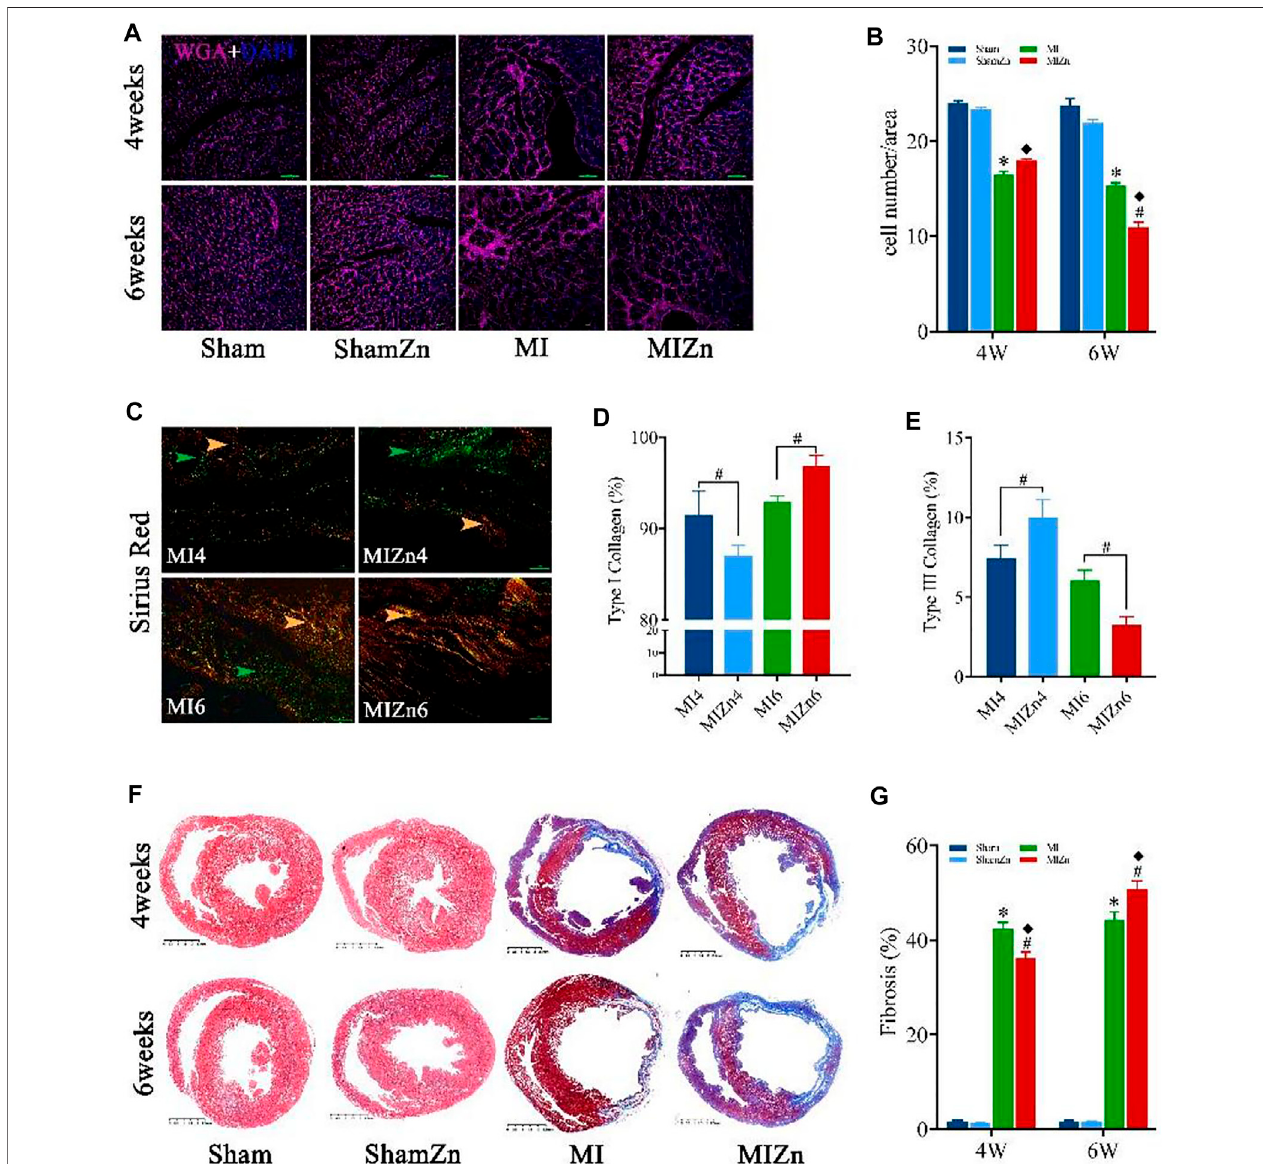
FIGURE 4 | Representative diagrams of WGA + DAPI redyeing (A) and statistical results of myocyte number per unit area (image magni fi cation: × 200 and scales: 50 µm) (B) ; Representative diagrams ofSirius red staining (C) and statistical results of type I collagen (yellow) (D) and type III collagen (green) (E) . Schematic panoramas ofMassonstaining (F) and statisticalresults ofmyocardium fi brosis (scales:2.5 mm) (G) .All ofthedata wereshown asMean ±SEM. * p < 0.05,MI vs. Sham; ◆ p < 0.05, ShamZn vs. MIZn; # p < 0.05, MIZn vs. MI.